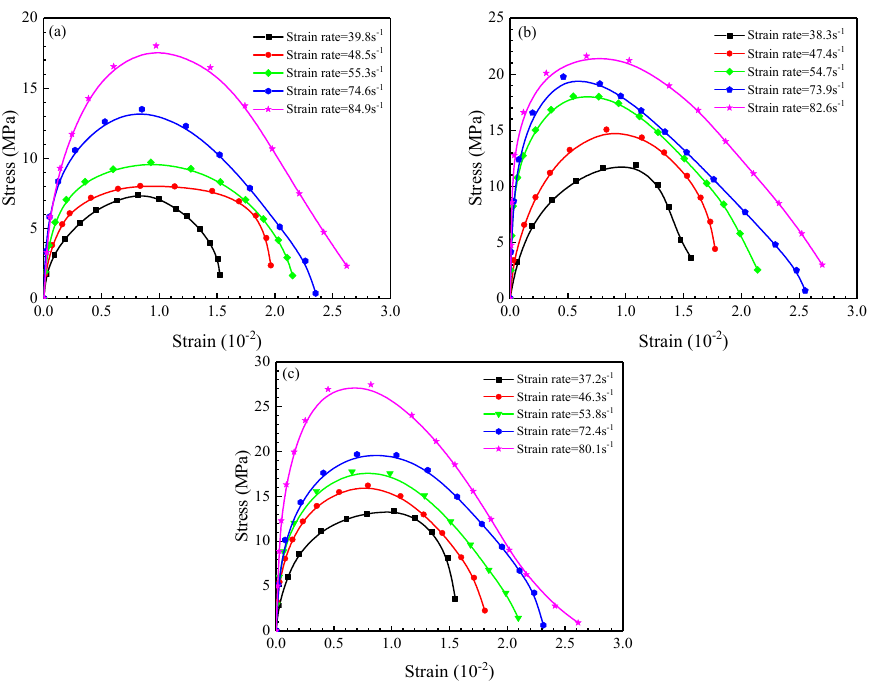
Figure 7. Dynamic stress–strain curves of S 5 series samples (i.e., 5 particle size components) under different strain rates. Talbot indices for the particle size distributions are: ( a ) T = 0.5; ( b ) T = 1.0; ( c ) T = 2.0.